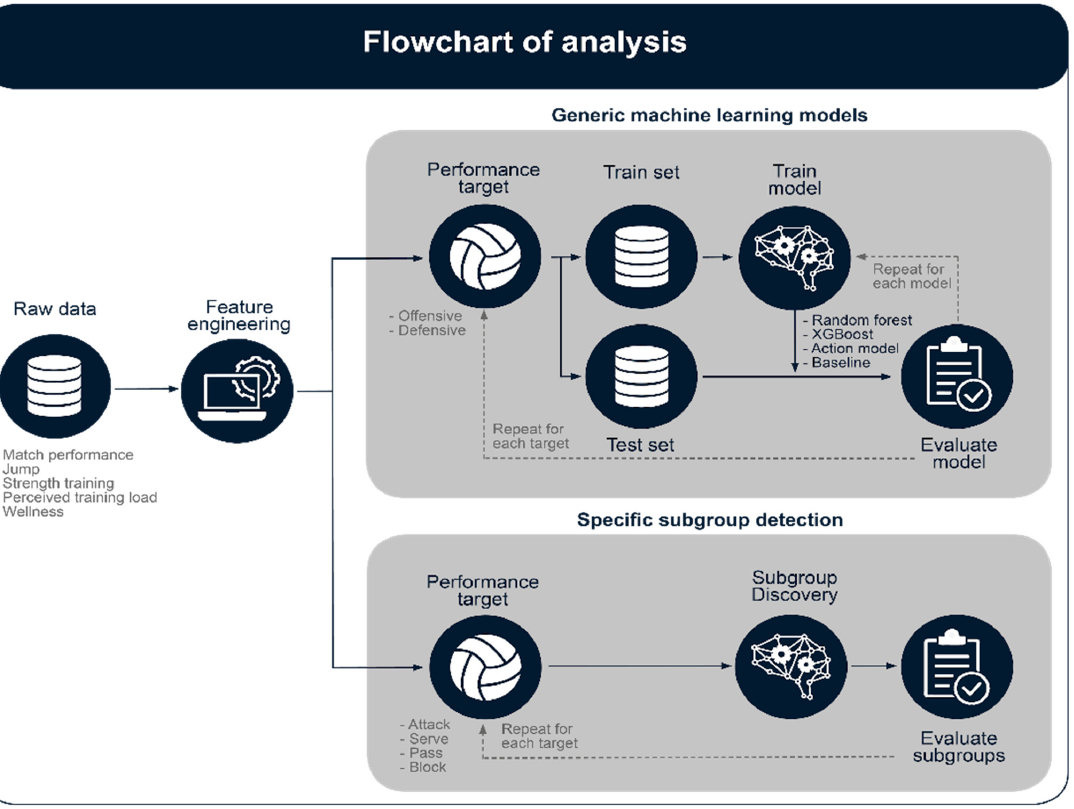
Figure 2. Flow chart of the analysis process for both the machine learning models and subgroup discovery analysis. Machine learning models were trained with hyperparameter tuning using 10-fold cross validation, whereas model performance was evaluated using the unseen test set. This analysis was repeated separately for offensive and defensive actions. Subgroup discovery results were evaluated with respect to the 5% false discovery probability (see Statistical Analysis). This analysis was repeated separately for attack, serve, block and pass actions.